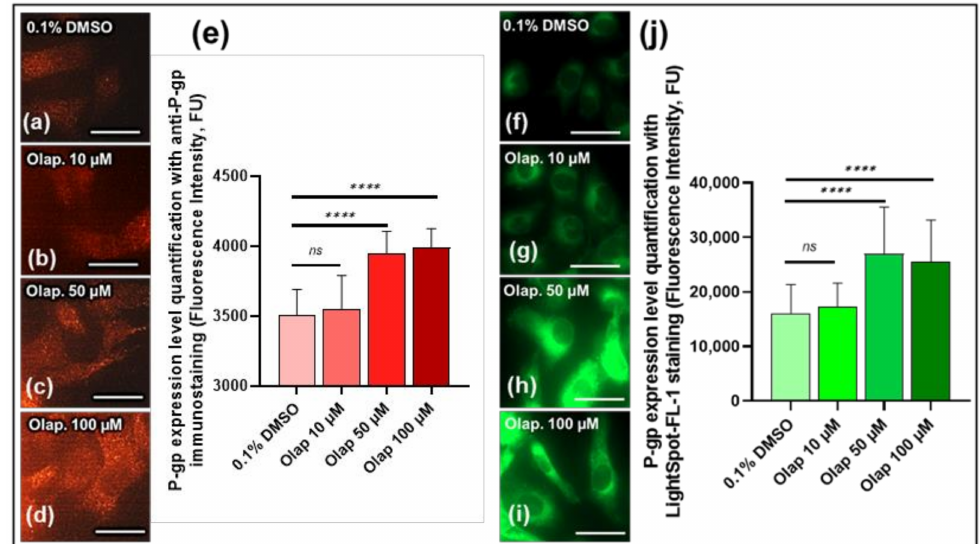
Figure 6. Comparison between anti-P-gp immunostaining and LightSpot ® -FL-1 fluorescent probe staining for P-gp level expression measure on the SUM1315 cell line in monolayer culture condition after increased Olaparib concentration exposure. SUM1315 cells were treated with 10, 50 or 100 µ M Olaparib for 3 h. Cells were then fixed and immunostained, combining anti-P-gp mouse antibody (F4 clone) and a goat anti-mouse secondary antibody, coupled to Alexa Fluor™ 568 (red signal) for each dose ( a – d ), and the signal was quantified using Gen5 software (BioTek ® ) ( e ). LightSpot ® -FL-1 staining (green signal) was also utilized for the same experimental conditions ( f – i ), and quantified using Gen5 software ( j ). All pictures were acquired with the Cytation™3 MV (BioTek ® , M = 4 X, scale bar = 50 µ m). Significances between conditions were indicated as ns (not significant; p > 0.05), and **** p <